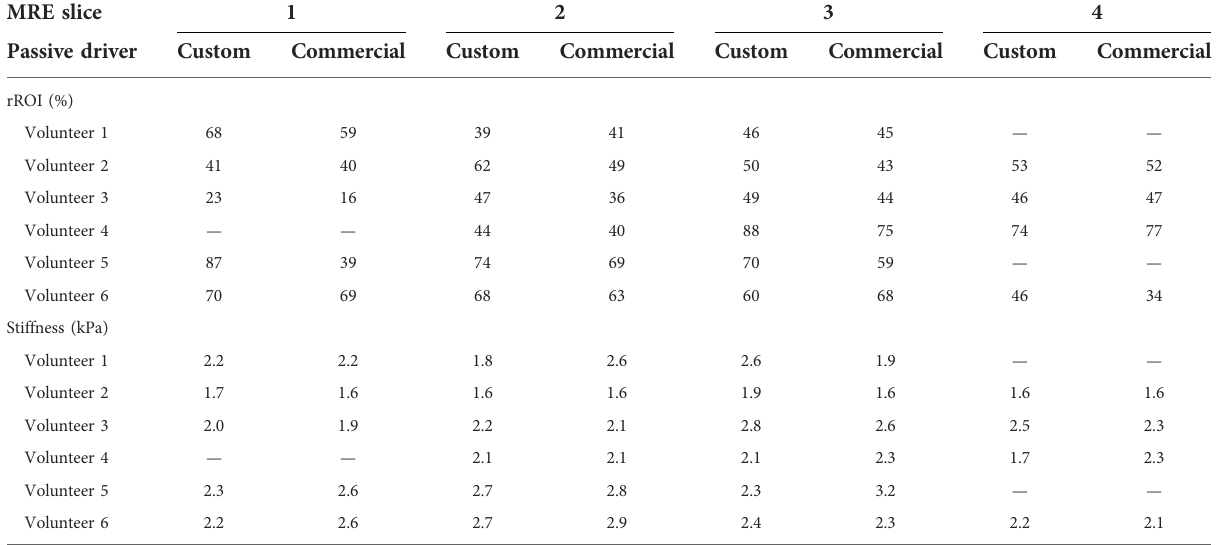
TABLE 2 Relative rROI area as fraction of the entire liver section per slice, expressed in %, obtained with the custom passive driver and the commercial one in adult volunteers, using the threshold excitation amplitude. The corresponding rROI-averaged stiffness values (kPa) are further provided per slice. Missing comparative values on the inferior or superior slice are due to anatomic mismatch. MRE